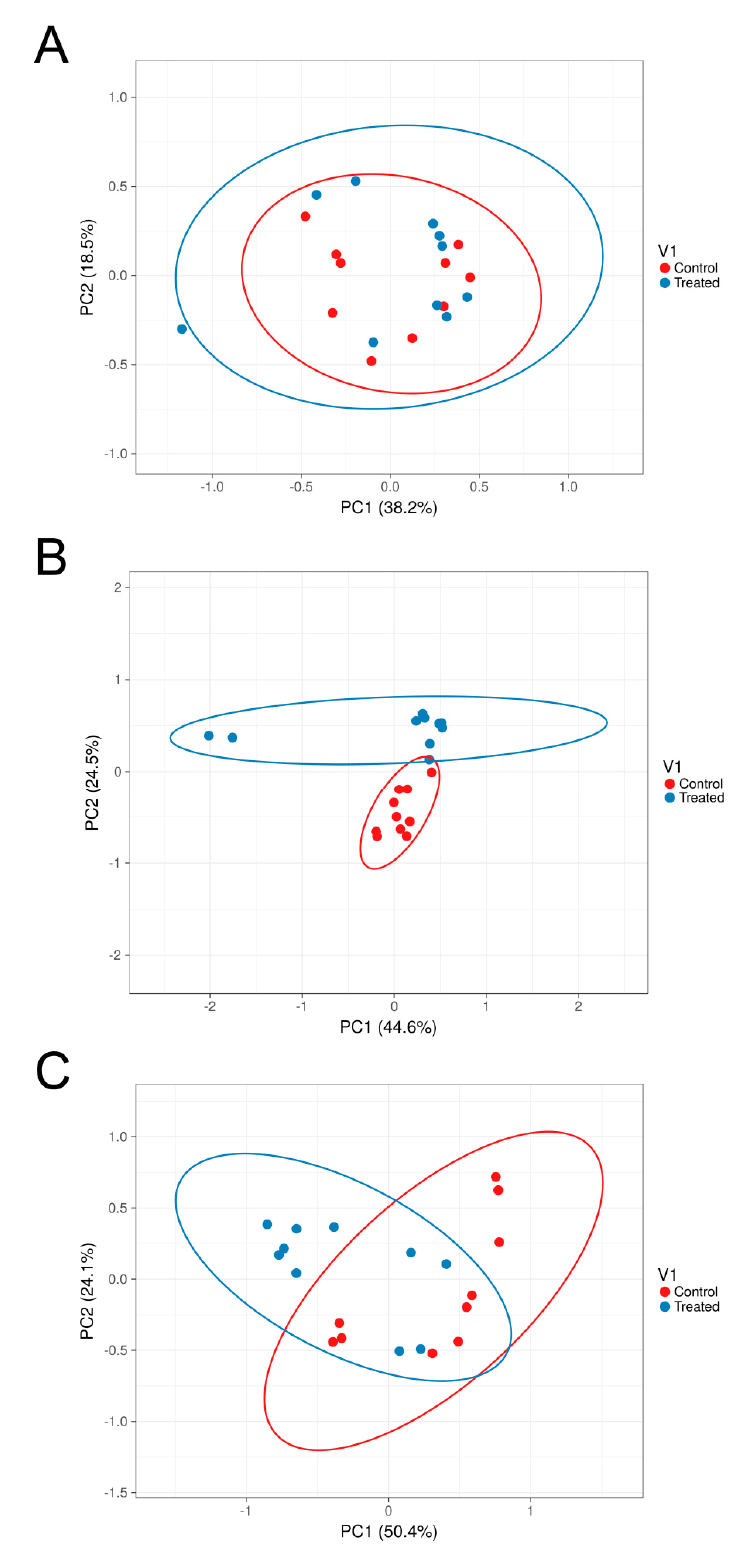
Figure 6. Beta diversity Principal Coordinates Analysis between traditionally ( n = 10) and alterna- tively fed water buffaloes ( n = 10). PCoA analysis based on Weighted UniFrac distance matrices between traditionally and alternatively fed water buffaloes in the rumen ( p -value = 0.25) ( A ), large intestine ( p -value = 0.002) ( B ) and feces ( p -value = 0.009) ( C ).